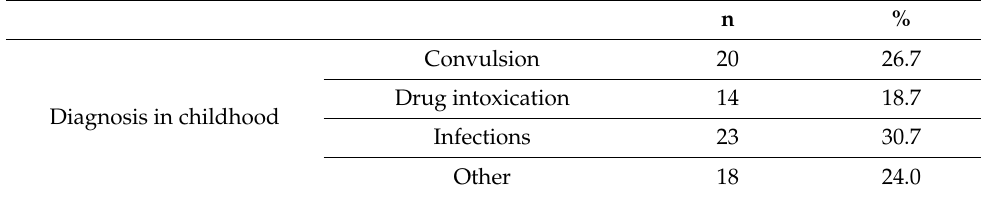
Table 1. Descriptive features of the